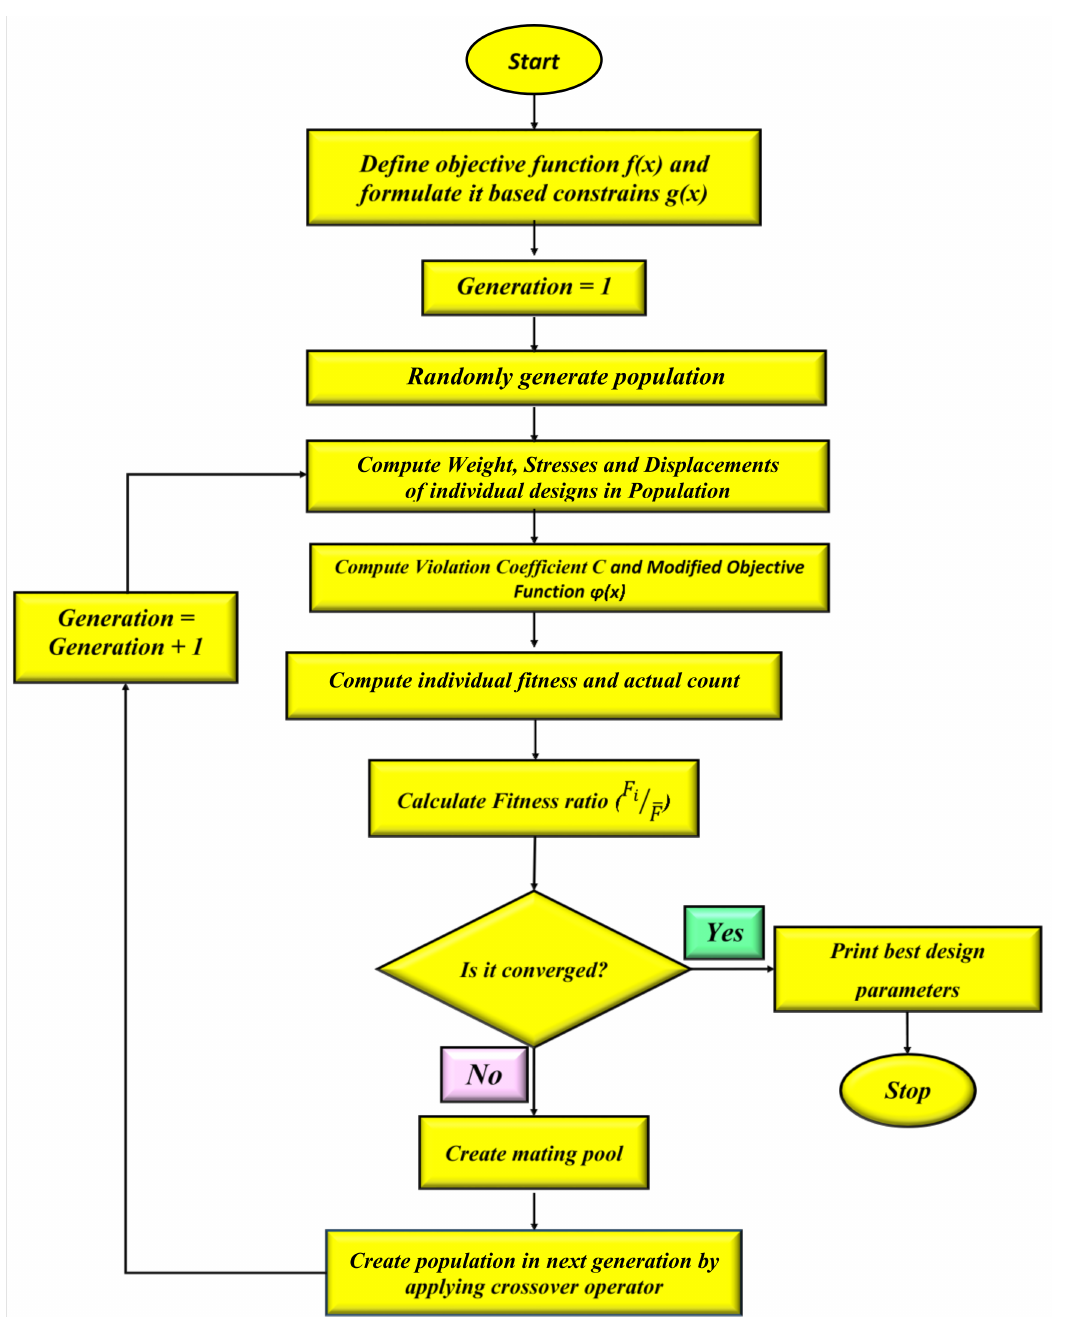
Figure 10. Genetic algorithm flowchart for sandwich panel